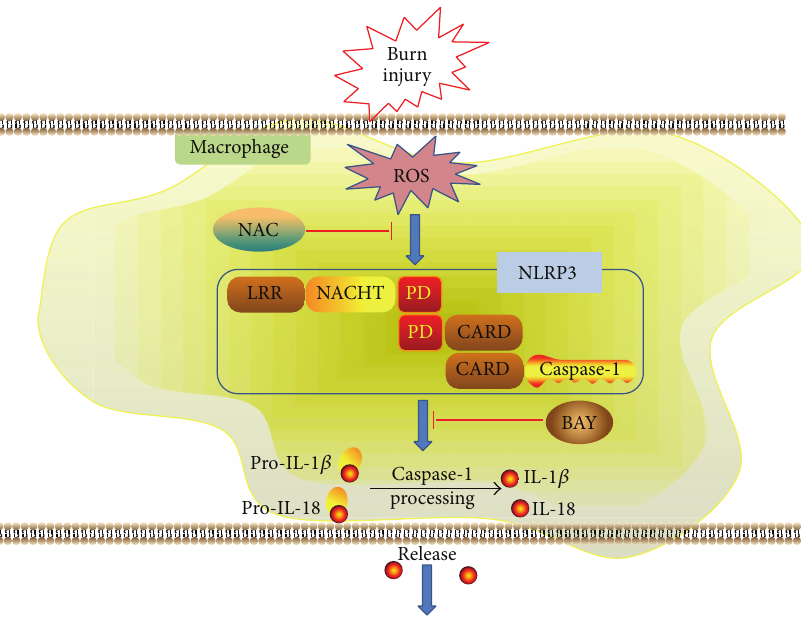
Figure 7: Model of ROS-mediated NLRP3 inflammasome activation in burn-induced acute lung injury. Burn injury activates ROS in macrophages and in turn the elevated ROS promote the activation of NLRP3 inflammasome and subsequent IL-1 𝛽 and IL-18 secretion. IL-1 𝛽 and IL-18 act as inflammation initiating cytokines and magnify inflammatory response. The amplified inflammatory responses lead to ALI. Blocking NLRP3 or ROS activation can alleviate